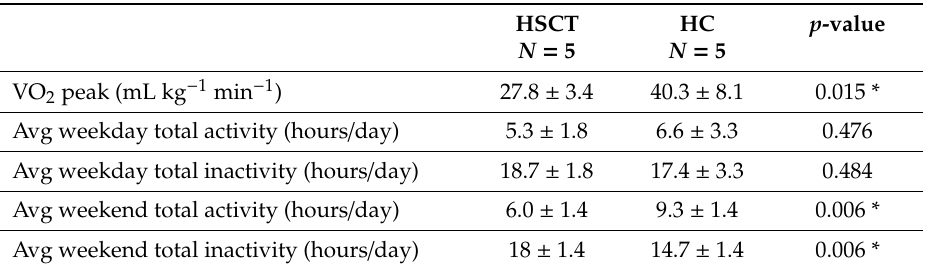
Table 2. Exercise